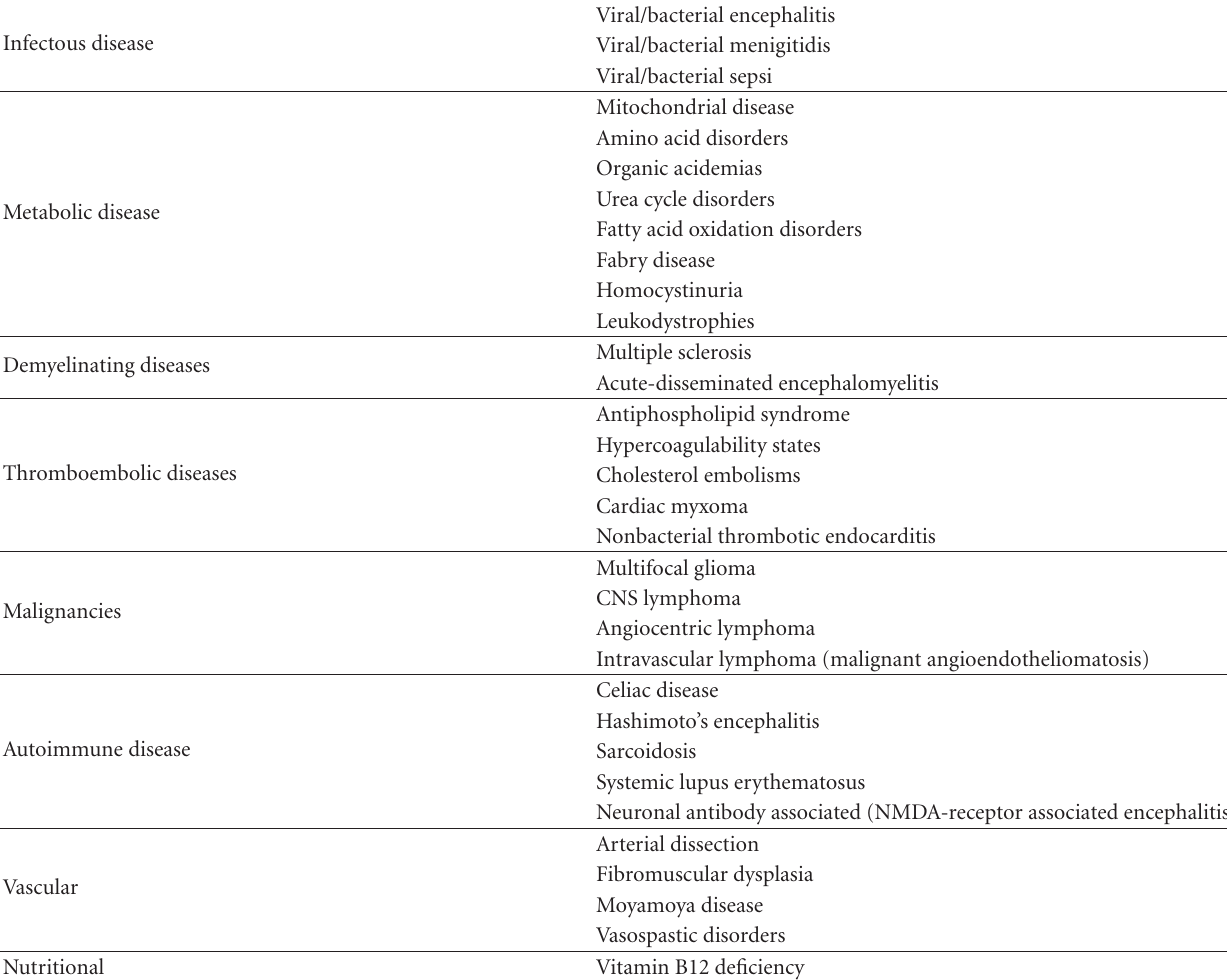
Table 3: Di ff erential diagnosis of CNS vasculitides in